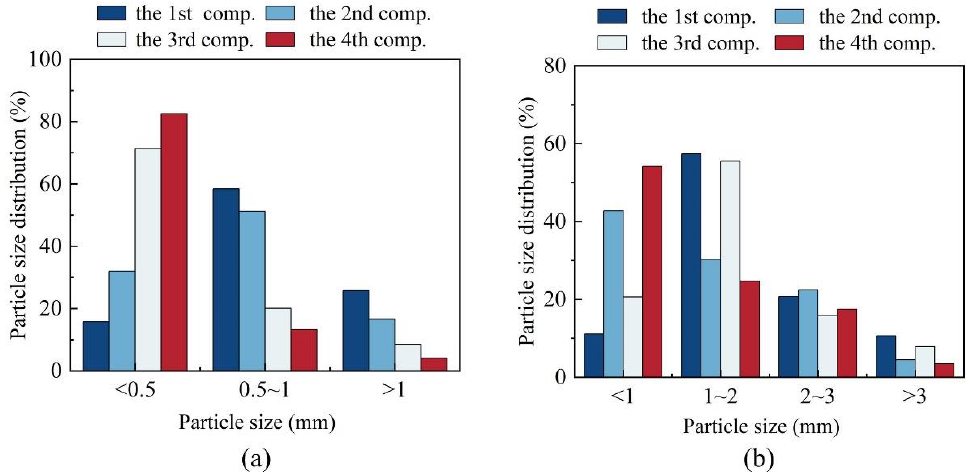
Figure 3. Grid size distribution of the granular sludge in four compartments on ( a ) the 35th day and ( b ) the 45th day during start-up.